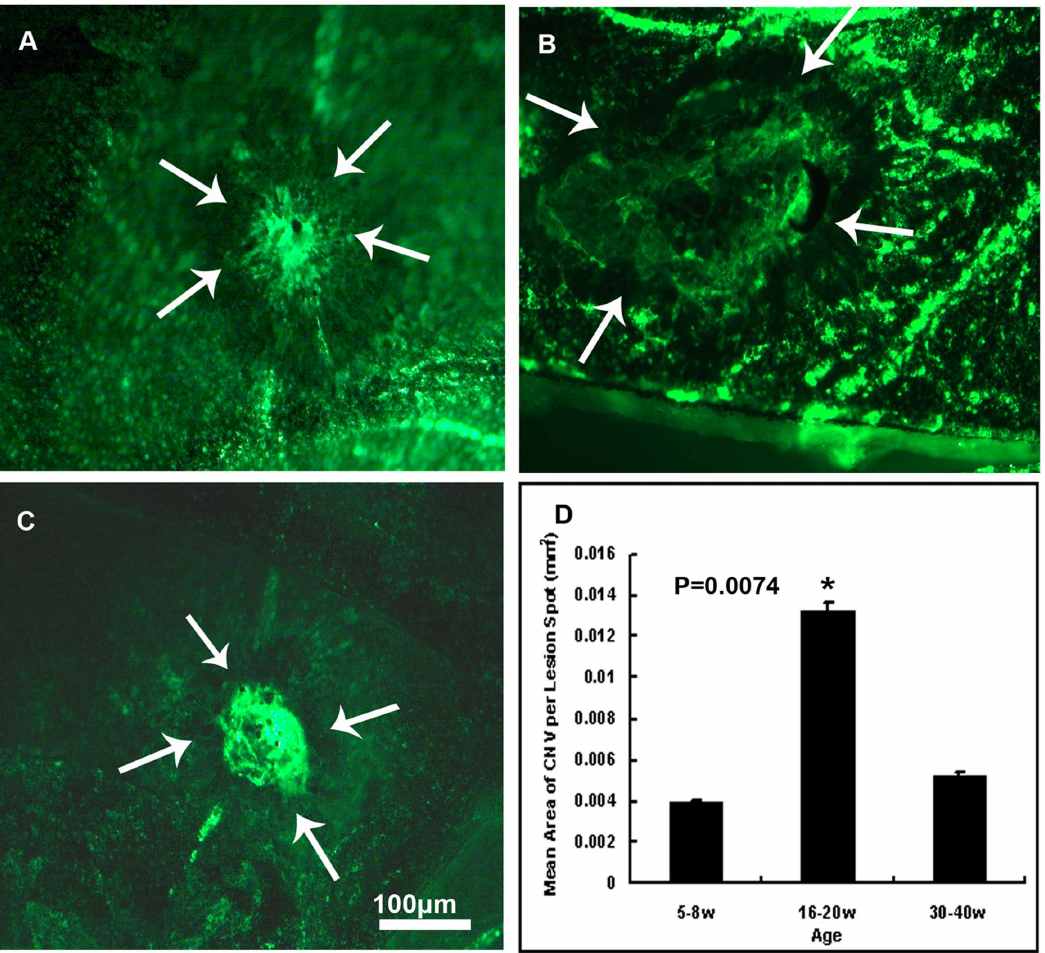
Figure 4. Mean area of CNV in mice of different ages. Statistical significance of CNV area was detected among mice aged 16–20 weeks, 5–8 weeks and 30–40 weeks (P=0.0074). There seemed to be significantly the biggest CNV area in mice aged 16–20 weeks compared with mice aged 5–8 weeks and 30–40 weeks. Female mice aged 5–8 (Fig. 4A), 16–20 (Fig. 4B) or 30–40 (Fig. 4C) weeks were given laser photocoagulation spots at 3, 12 and 9 o’clock positions 1PD away from the optic disc in the posterior pole of retina of each eye with a cover slide placed on the cornea as a contact lens. After 2 weeks, mice were perfused with fluorescein-labeled dextran and choroidal flat mounts were examined by fluorescence microscopy. The area of CNV of each spot was measured by image analysis and data were analyzed by one-way ANOVA and expressed as mean + 2 SEM, as was shown by the bars (Fig. 4D). Mice aged 16–20 weeks showed significantly biggest mean area of CNV compared with mice aged 5–8 weeks and 30–40 weeks (P=0.0074). But there showed no statistical significance of mean area of CNV between 5–8 week-old and 30–40 week-old mice. (n=7mice/ group).